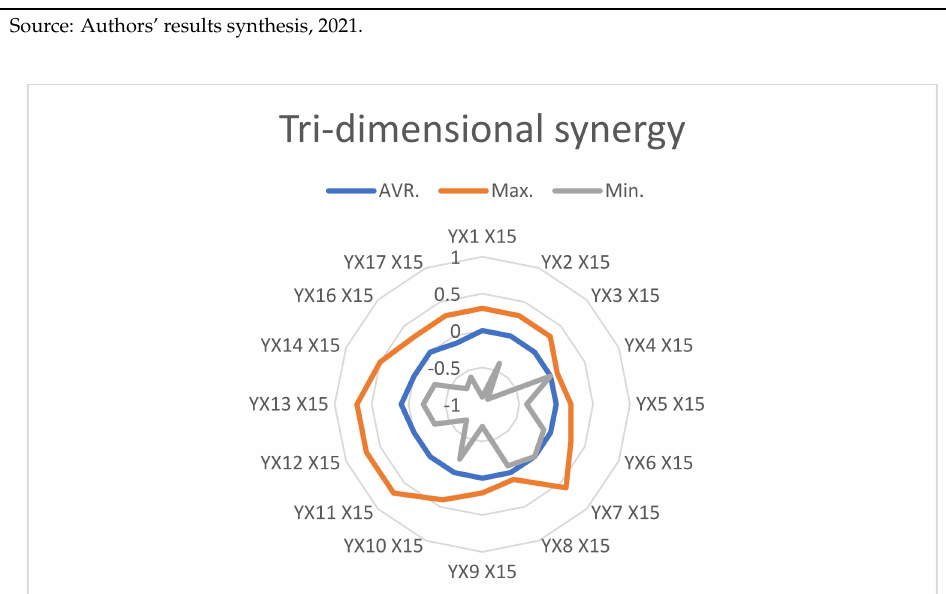
Figure 8. Tri-dimensional synergies in rapport with Employment in the energy sector (X 15 ). Source: Authors’